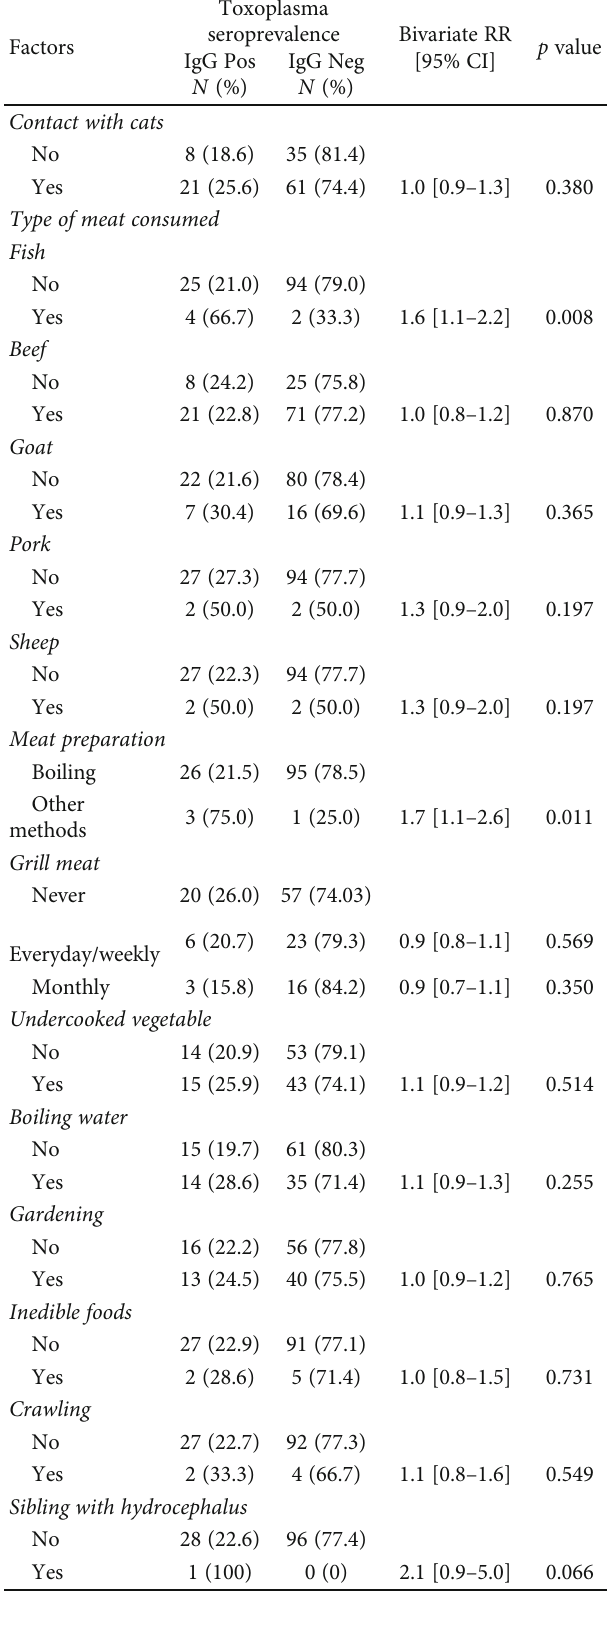
Table 4: Other risk factors associated with T. gondii transmission.